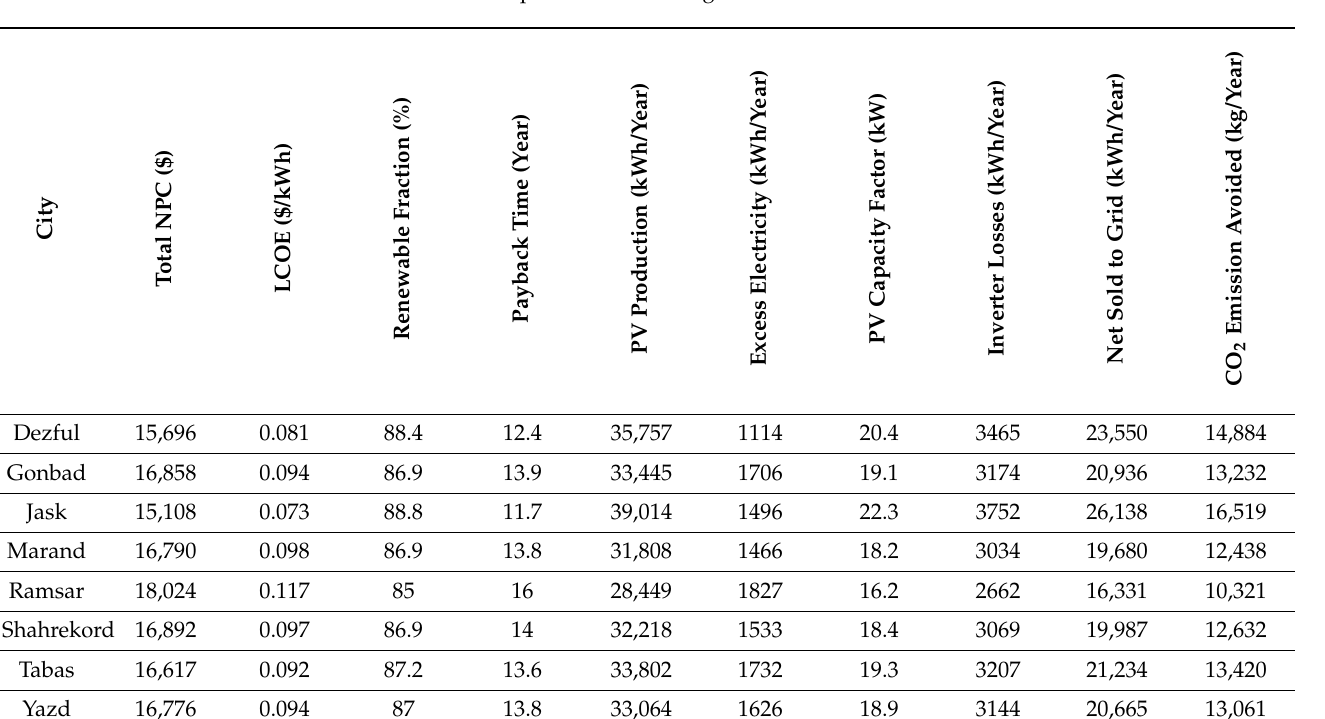
Table 11. The 30 ◦ slope decision-making matrix.